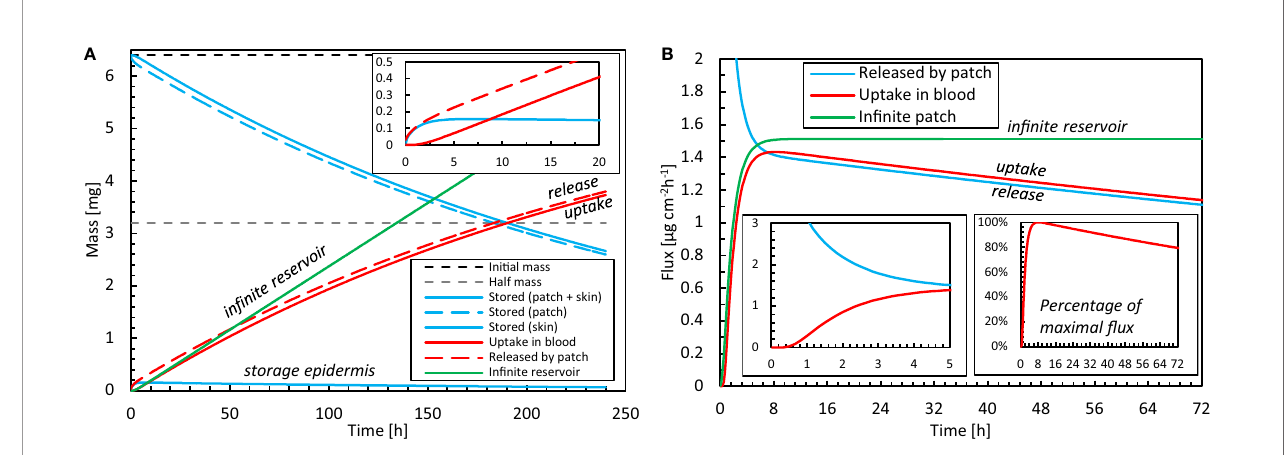
FIGURE 6 | (A) Amount of drug stored in the epidermis [m ep,stor (t)] and patch [m pt,res (t)], and cumulative amounts of drugs released by the patch m pt,rel (t) and taken up by the blood fl ow m bl,up (t) as a function of time for the base case. The initial amount of drugs is also shown. (B) Corresponding fl ux released by the patch into the epidermis (g pt,rel ) and taken up by blood (g bl,up ) as a function of time, where one insert shows the percentage for the maximal value. The results of an in fi nite reservoir are also